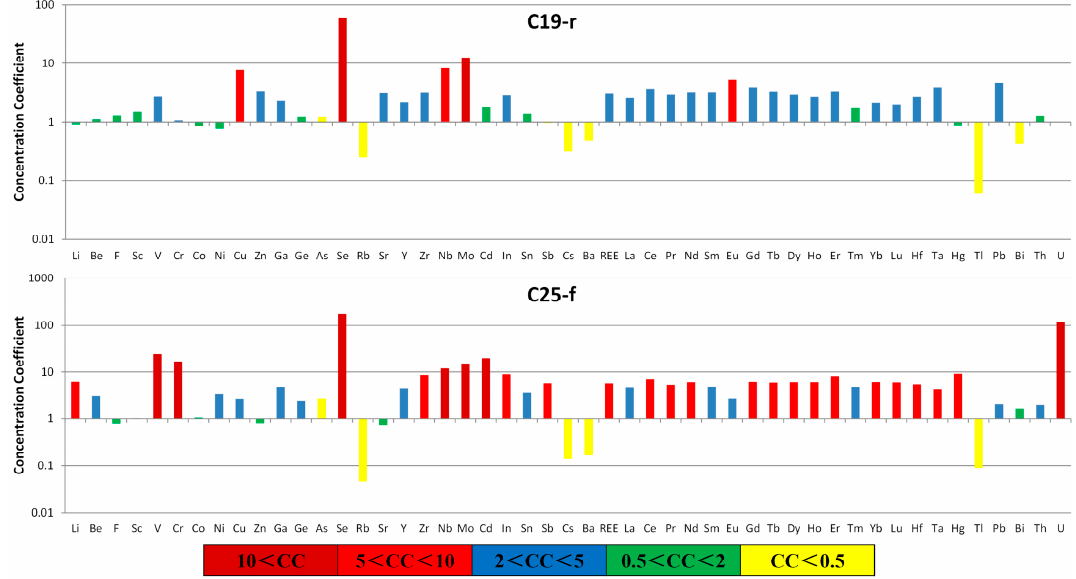
Figure 13. Concentration coefficients (CCs) of trace elements in the Shiping roof and floor samples, normalized by average trace element concentrations in clay of the world [30].